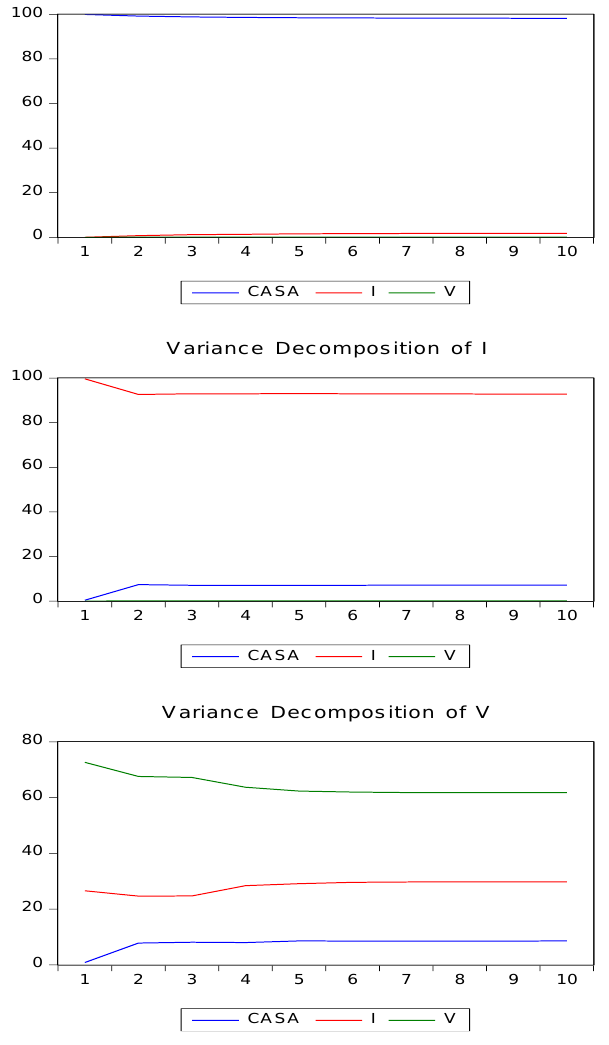
Figure 1: Variance